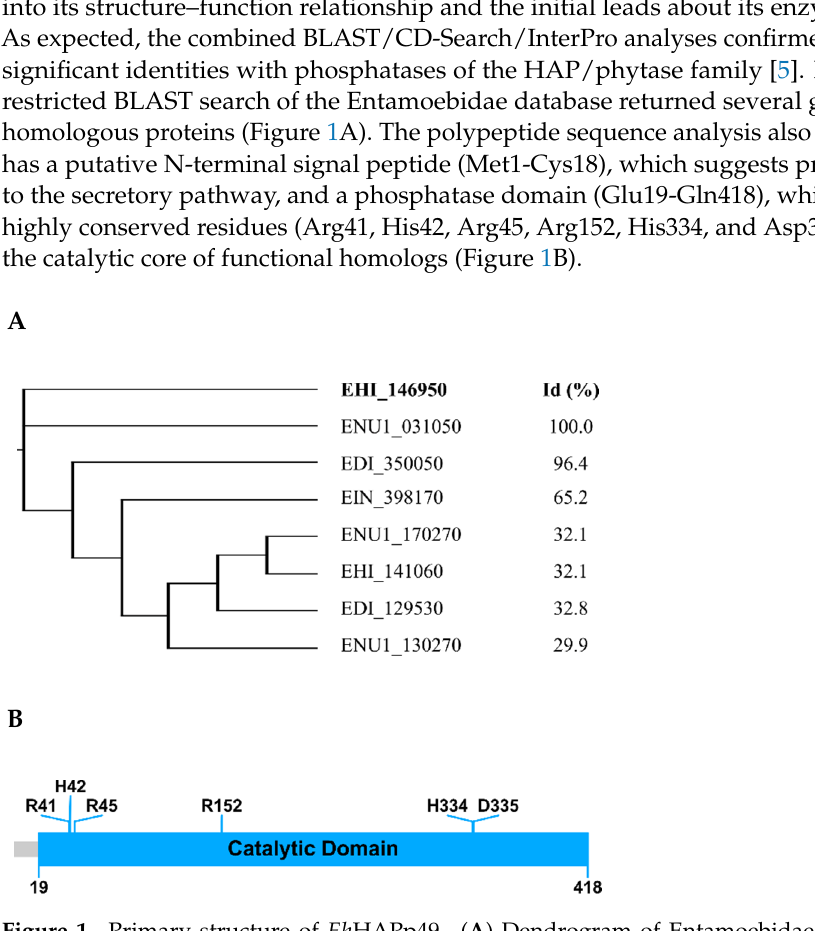
Figure 1. Primary structure of Eh HAPp49. ( A ) Dendrogram of Entamoebidae genes encoding protein homologs ( left ) and corresponding pairwise identities ( right ). ( B ) Domain architecture representation. Colored rectangles: signal peptide ( grey ) and phosphatase domain ( blue ). Predicted residues involved in catalysis are also denoted ( top ).